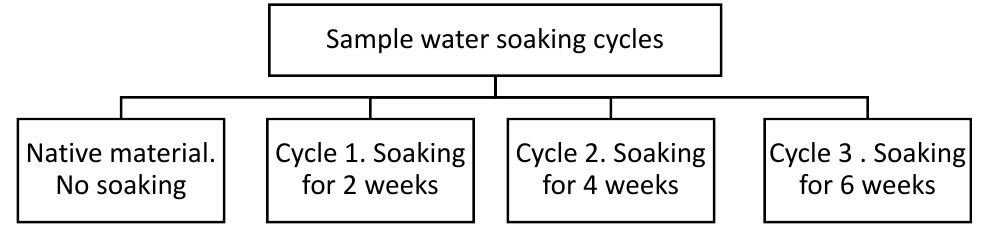
Figure 1. Number and duration of soaking cycles of wood samples in water.